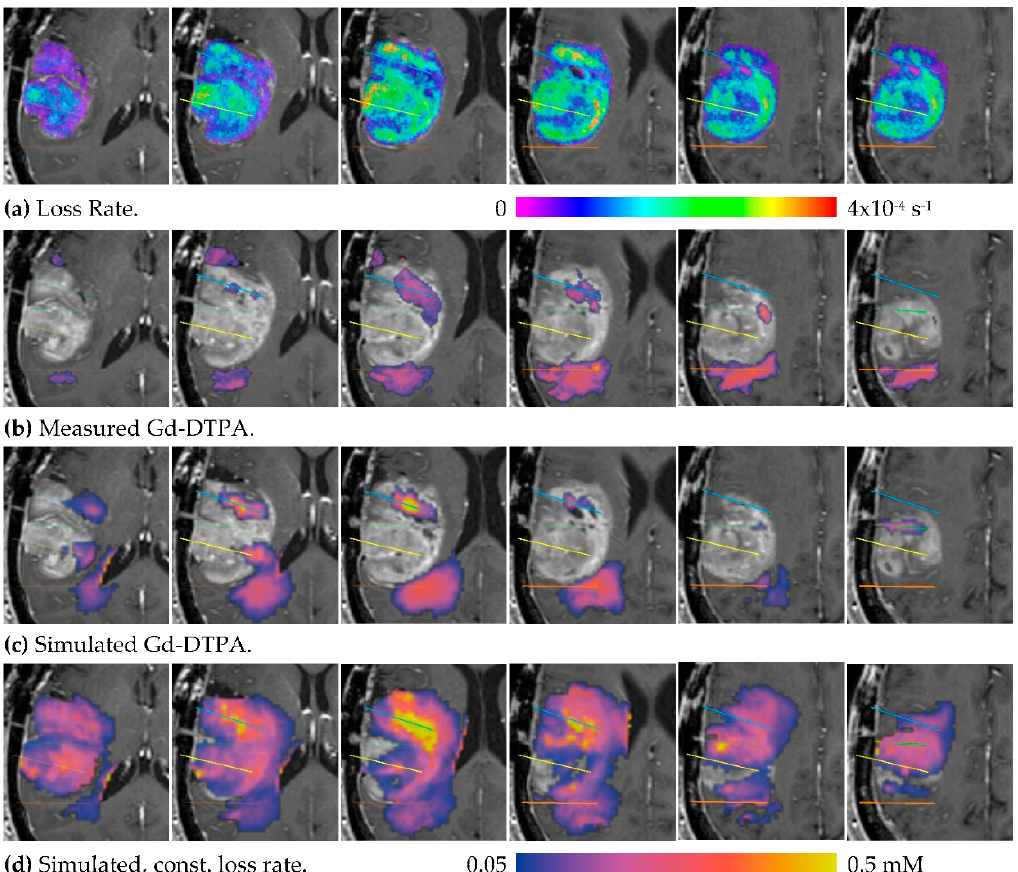
Figure 7. Infusion into large enhancing tumor (MR1-1 Patient 8). Loss rate and concentrations, in color, are overlaid on pre-infusion T1-weighted MRI, six axial slices, 6 mm apart. ( a ) Gd-DTPA capillary loss rate (technically, K trans ) measured from DCE. ( b ) Measured Gd-DTPA concentration after 24 h. ( c ) Simulated Gd-DTPA concentration, using measured loss rate. ( d ) Simulated Gd-DTPA concentration, using constant normal-tissue loss rate (1 × 10 − 6 s − 1 ).